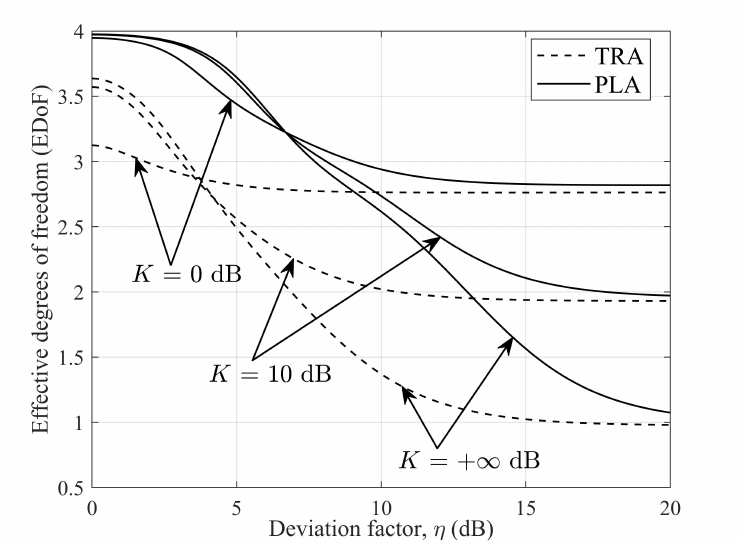
Figure 6. EDoF as a function of η , with ¯ γ = 10 dB and different Ricean factors K .